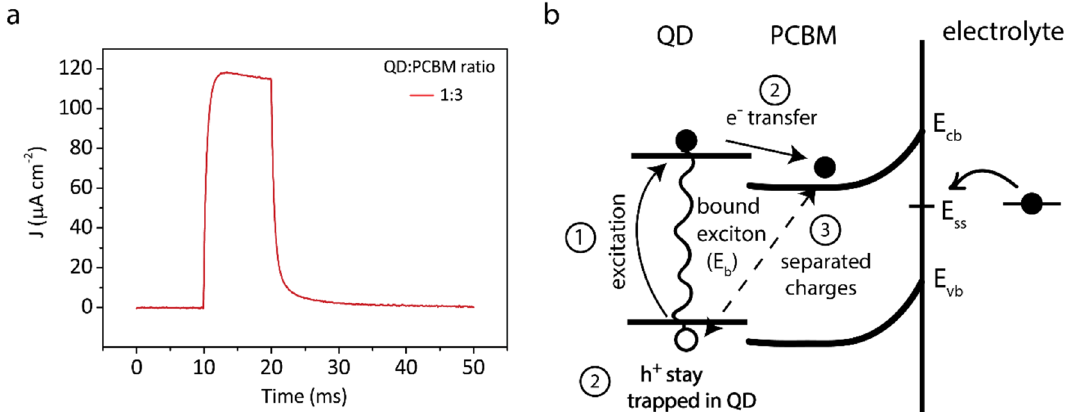
Figure 5. ( a ) Photocurrent density of the InP/ZnS-based photoelectrode with InP/ZnS:PCBM ratio of 1:3. ( b ) Schematic showing qualitatively the proposed ongoing processes at the QD:PCBM-electrolyte interface upon illumination. The processes are numbered according to their occurrence sequence. E cb , E vb , E ss stands for conduction band, valence band and surface state energy levels,